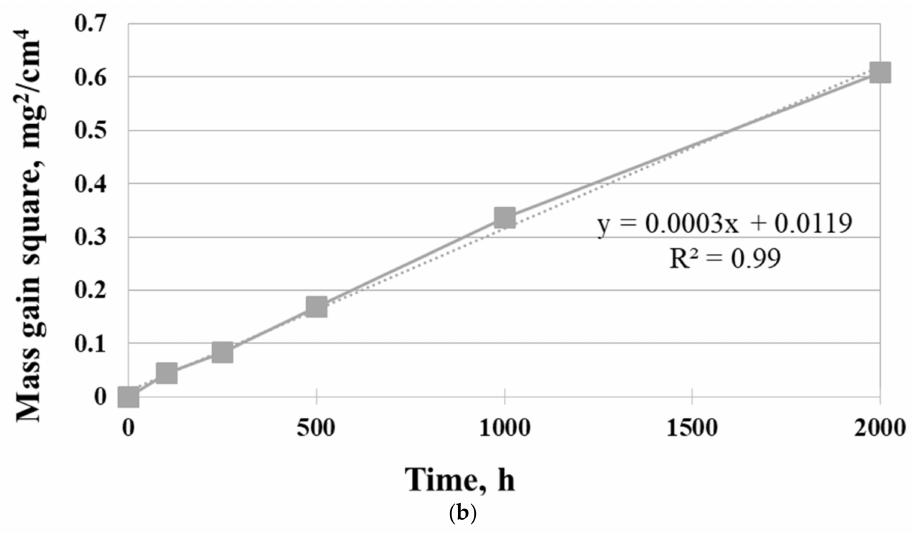
Figure 4. Oxidation behavior of Inconel 740H alloy in a steam atmosphere under atmospheric pressure at 750 ◦ C: ( a ) mass gain and ( b ) square of the mass